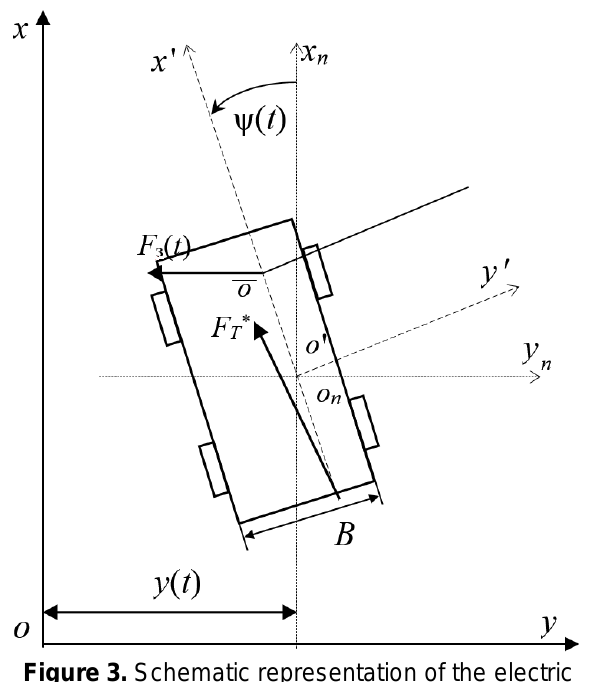
Figure 3. Schematic representation of the electric bus movement relative to a given